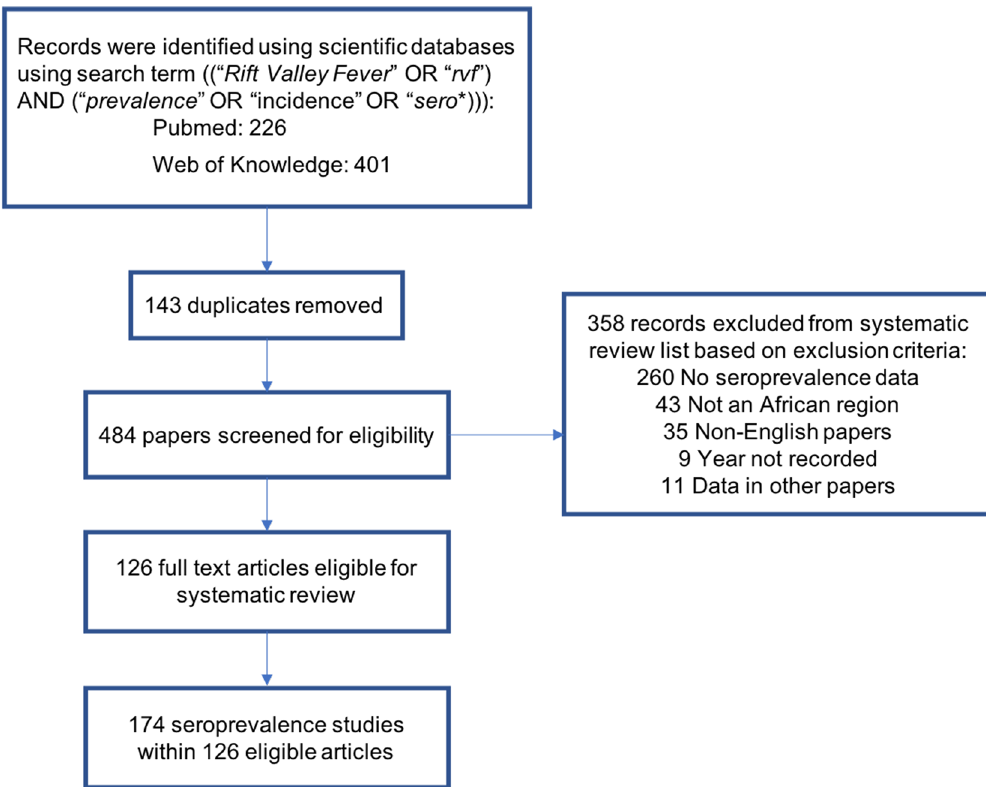
Fig 1. Flowchart for the systematic review to identify eligible studies of Rift Valley fever virus (RVFV) seroprevalence in Africa.